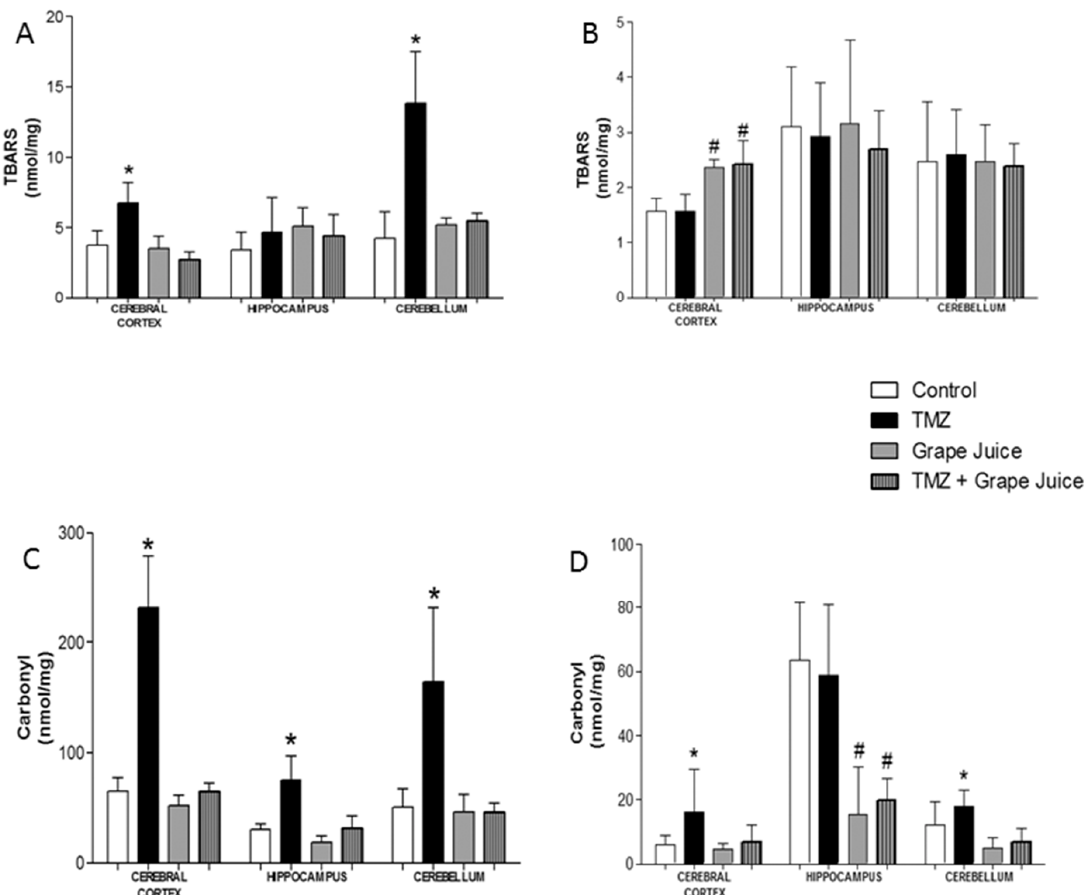
Figure 1. Effect of temozolomide (TMZ) and pre-incubation with purple grape juice on thiobarbituric acid reactive substances (TBARS) ( A ) and carbonyl ( C ) and effect of co-incubation with TMZ and purple grape juice on thiobarbituric acid reactive substances (TBARS) ( B ) and carbonyl ( D ) in the cerebral cortex, hippocampus, and cerebellum of rats. Data are expressed as mean ± standard deviation. p < 0.05 from other groups; # p < 0.05 from control and TMZ. N = 8–10 animals/group.